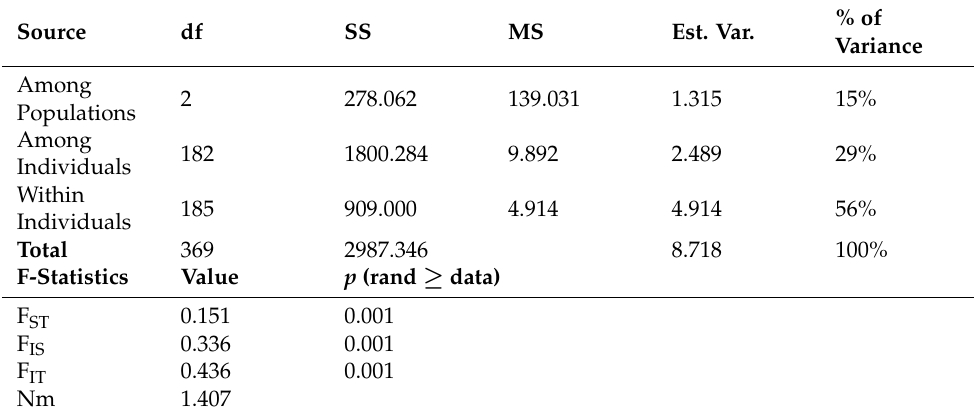
Table 4. Analysis for molecular variance of 163 Mithun, 10 gaur, and 25 Tho-tho cattle populations (AMOVA).